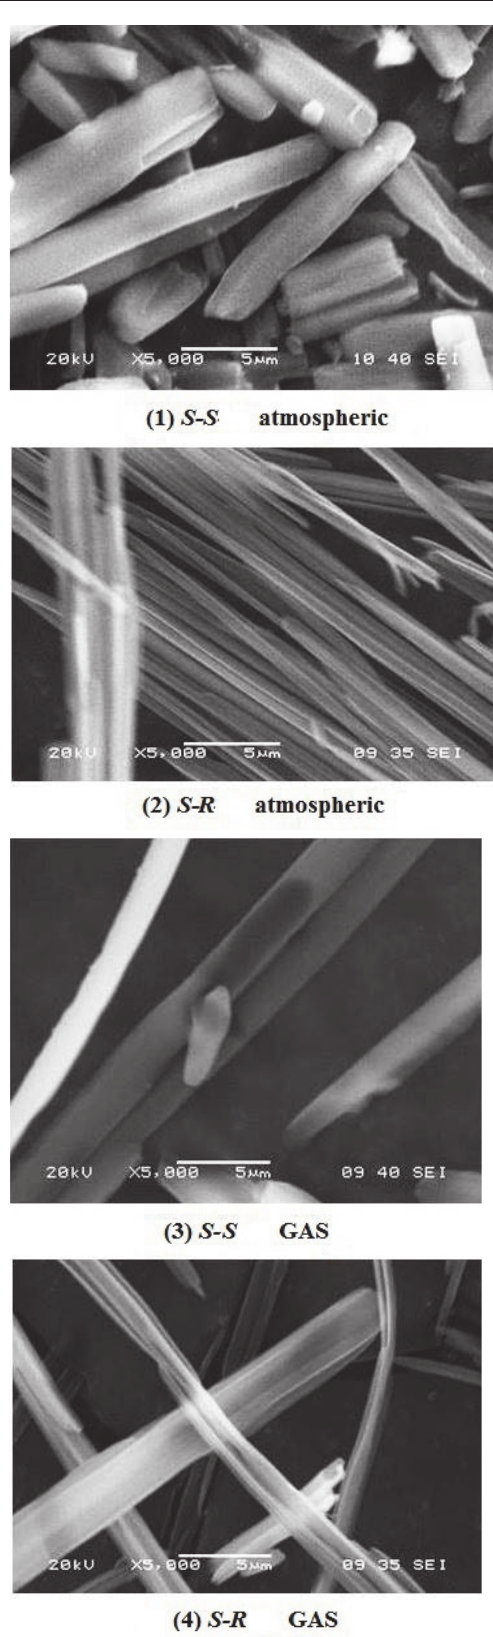
Fig. 4 SEM Pattern: (1 and 2) ( S;S )- and ( S;R )-salt, atmospheric condition (40 °C, 1 h, without CO 2 pressure , (3 and 4) ( S;S )- and ( S;R )-salt, GAS condition (40 °C, 1h at 12 MPa CO 2 pressure, 8.8 g CO 2 /g solvent)